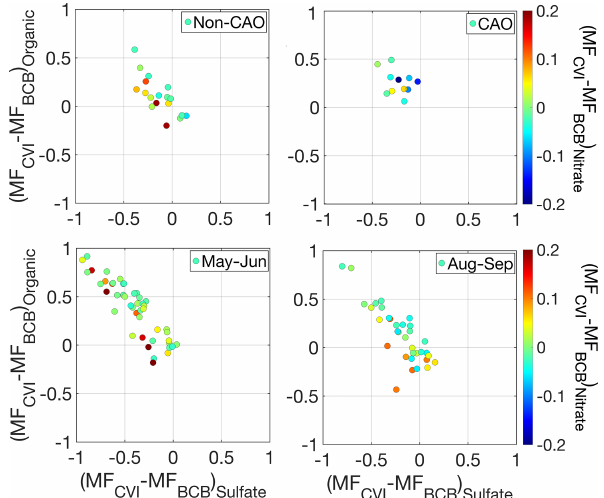
Figure 5. Scatterplot of the difference in organic mass fraction in cloud legs with CVI data and below cloud base (BCB) legs for an individual cloud ensemble relative to the analogous difference for sulfate mass fraction between the same pair of legs. Markers are colored by the analogous difference in nitrate mass fraction. Pan- els represent different seasons with winter deployments (January– March) separated into CAO and non-CAO